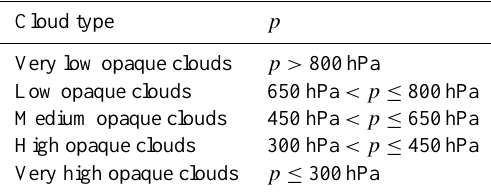
Table 1. Cloud types of CM SAF CTY parameter and correspond- ing pressure levels (see Derrien